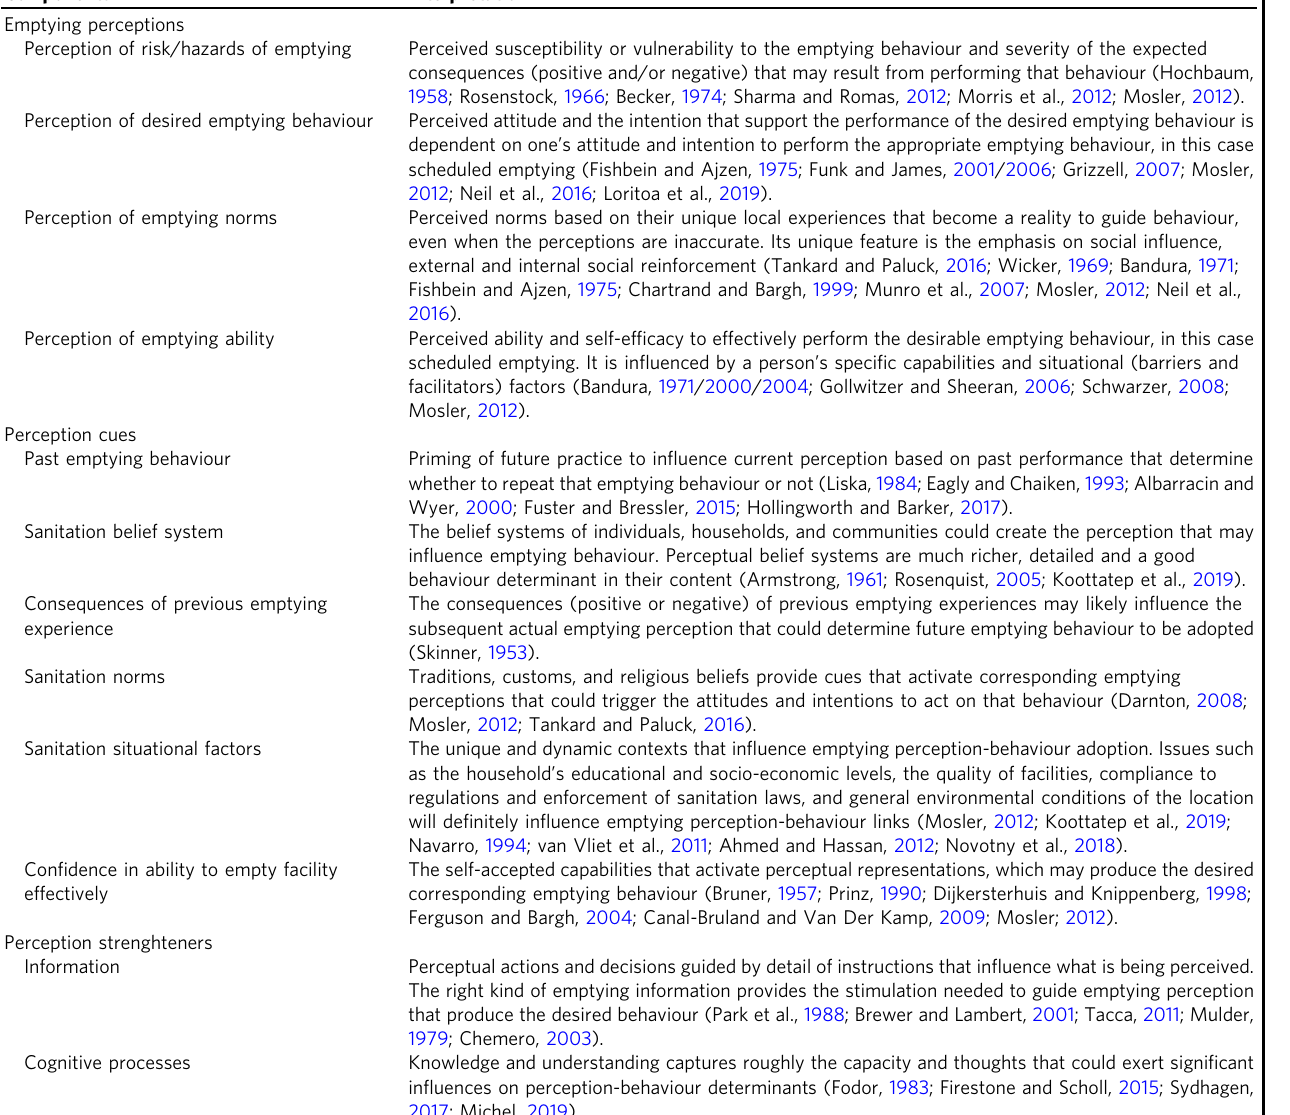
Table 1 Interpretation of components of the non-sewered sanitation emptying perception-behaviour